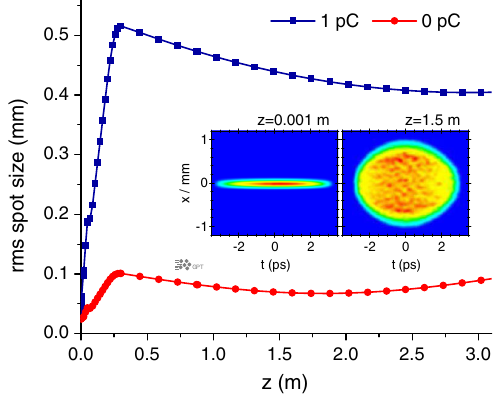
FIG. 1. GPT simulations of cigar beam dynamics in rf photo- injectors: transverse beam sizes along the Pegasus beam line for 1 pC and 0 pC (space charge effects switched off). The simu- lation parameters match the experimental ones reported in Table I. With proper initial conditions, the space charge domi- nated expansion leads to the creation of a nearly ideal uniformly filled ellipsoidal distribution (inset).